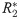
Multi-planar reconstructions of the RESUME maps.Axial (a), coronal (b) and sagittal (c) brain slices of: 1) R2* map ([0 ∼ 50] s−1); 2) R1 map ([0 ∼ 2] s−1); 3) PD map ([0 ∼ 1] arbitrary units); 4) QSM ([−300 ∼ 300] ⋅ 10−9) maps. The axial and coronal slices are centered at the level of the cerebellar dentate nuclei (remarkably conspicuous in the R2* and QSM maps due to their increased iron content); the sagittal slice is centered on the midline, where the deoxyhemoglobin-rich intracranial veins are particularly evident in the R2* and QSM maps.